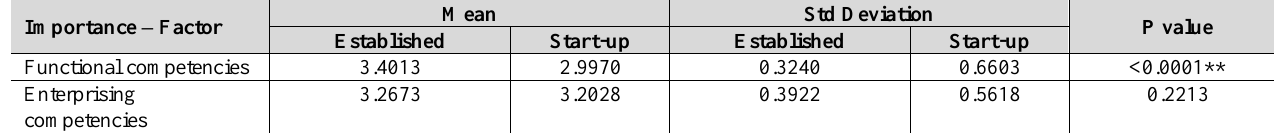
Table 4: Independent t-test - on importance of functional and enterprising competencies Importance – Factor